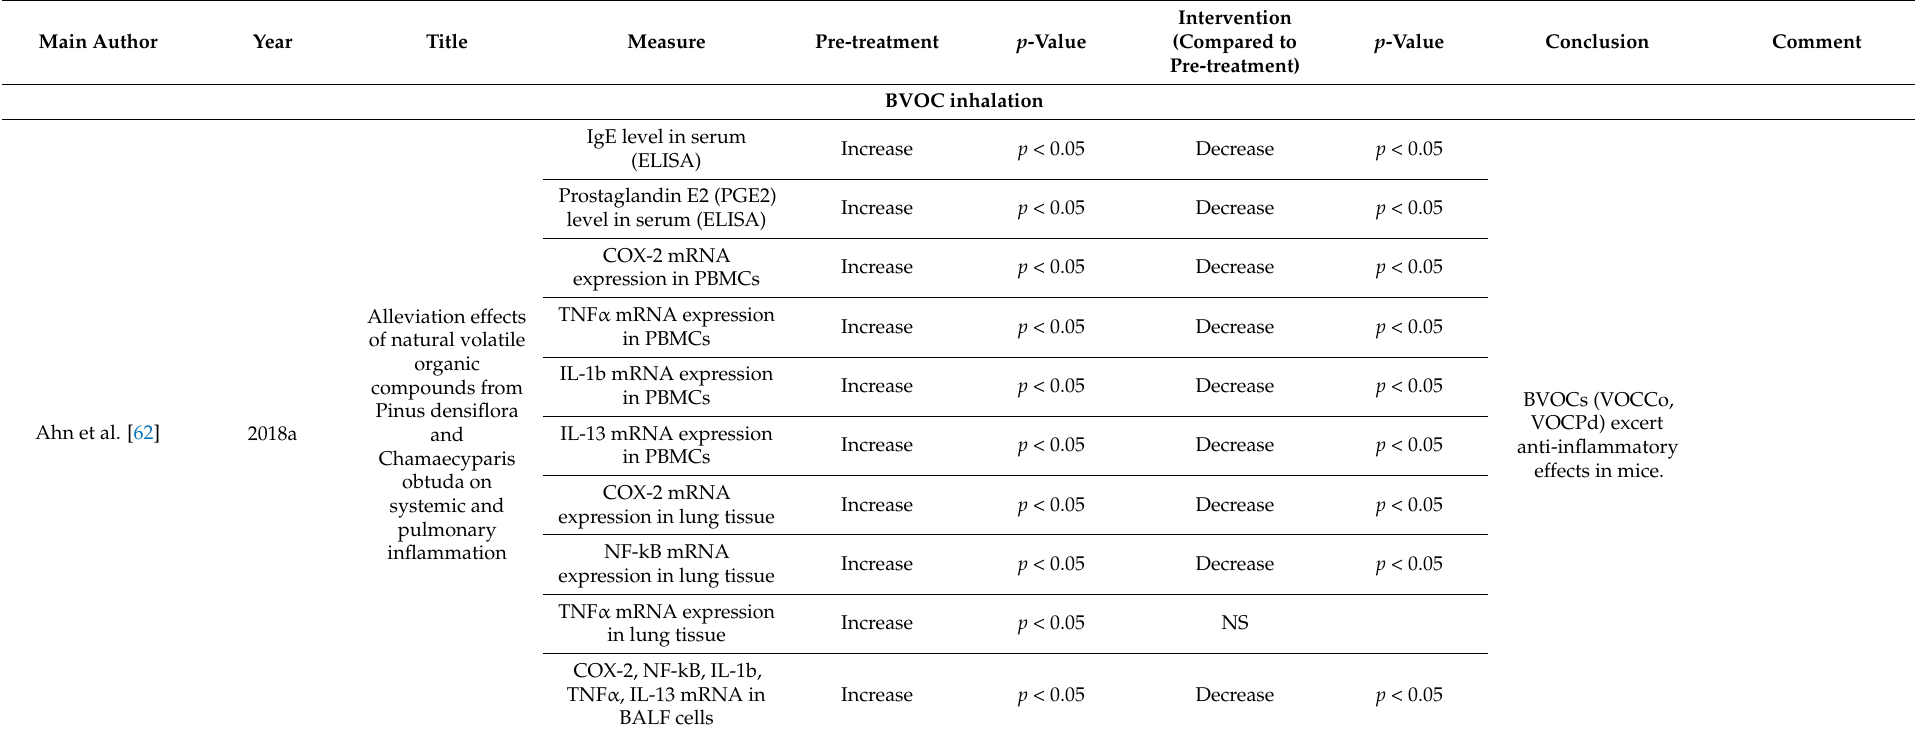
Table 6. Outcomes of animal studies. Significances are given with p < 0.05, p < 0.01 and p < 0.001; NS = not significant, NA=not applicable. A non-significant trend is described as “Decrease/Increase, NS”. If significances are not given, it is described as “Decrease/Increase,